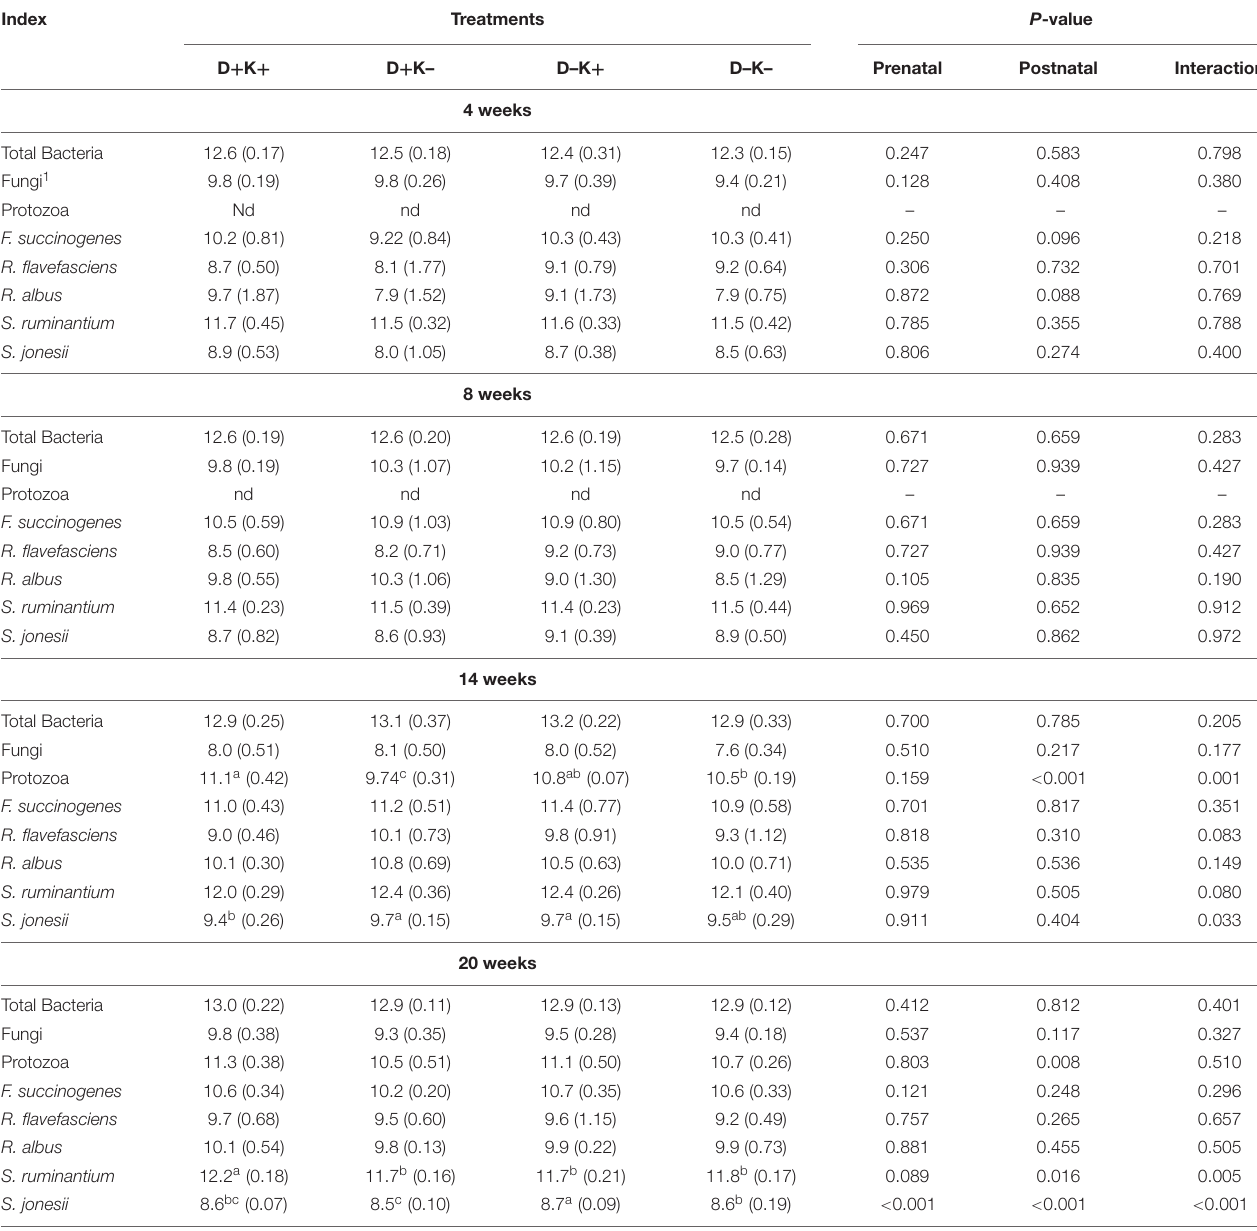
TABLE 2 | Mean (standard deviation) of absolute abundance of target rumen microbes determined by real-time PCR (log 10 /mL rumen fluid) of goat kids at 4, 8, 14, and 20 weeks of